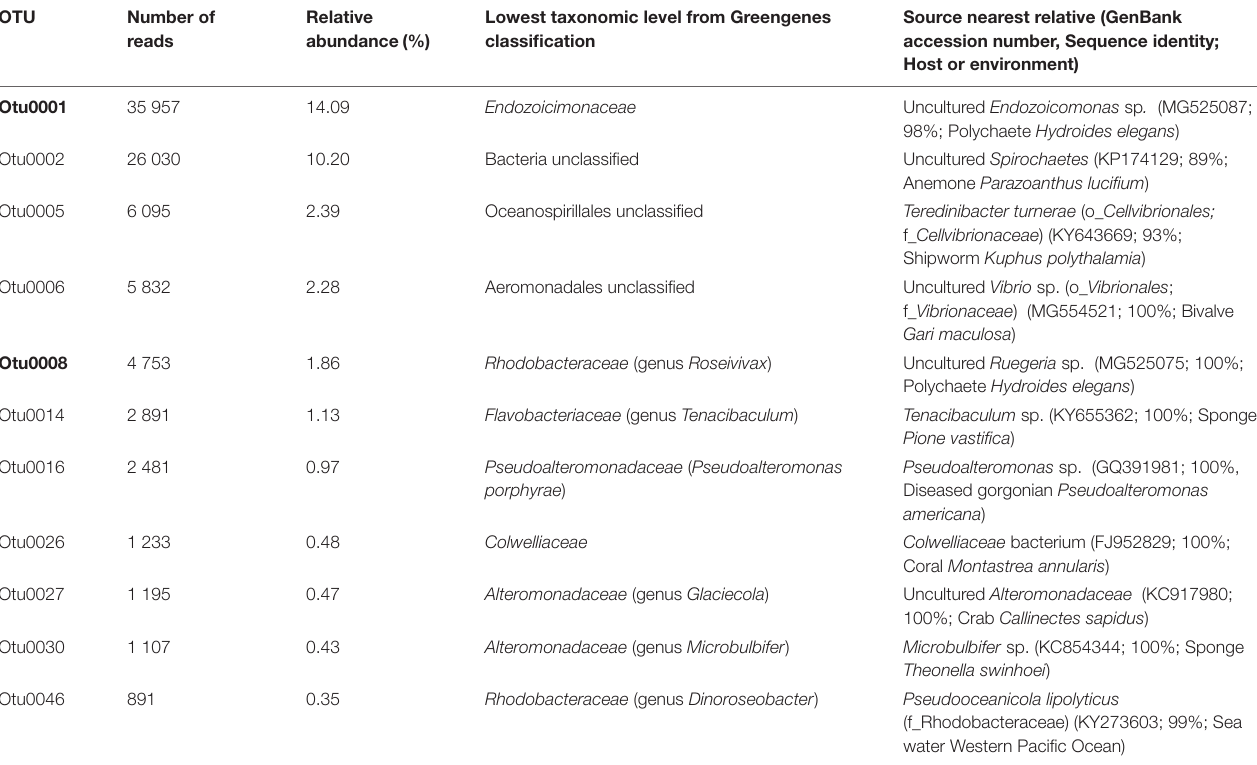
TABLE 1 | Summary of bacterial OTUs corresponding to the core microbiome of the pearl oyster Pinctada margaritifera . OTU Number of Relative Lowest taxonomic level from Greengenes reads abundance(%) classification